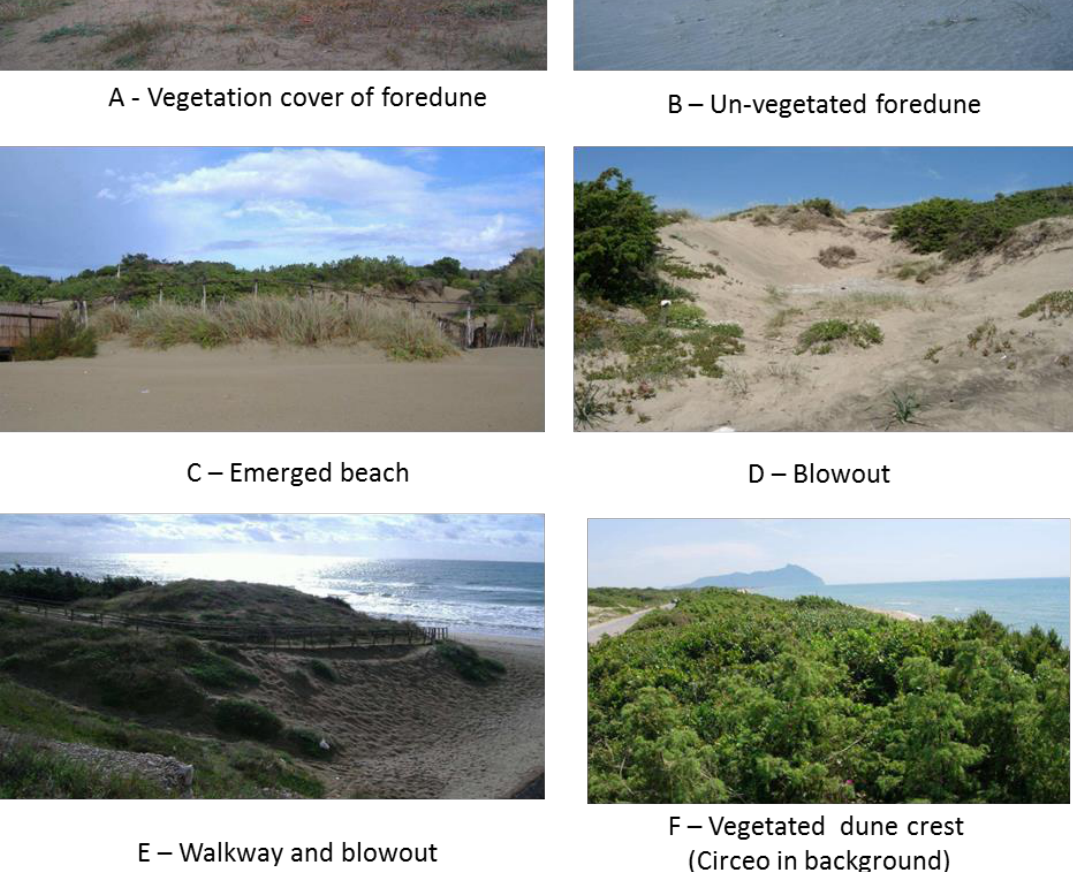
Figure 2. Pictures of different parts of the study area. ( A ) Vegetation cover of foredune; ( B ) Un-vegetated foredune; ( C ) Emerged beach; ( D ) Blowout; ( E ) Walkway and blowout; ( F ) Vegetated dune crest (Circeo in backfround)